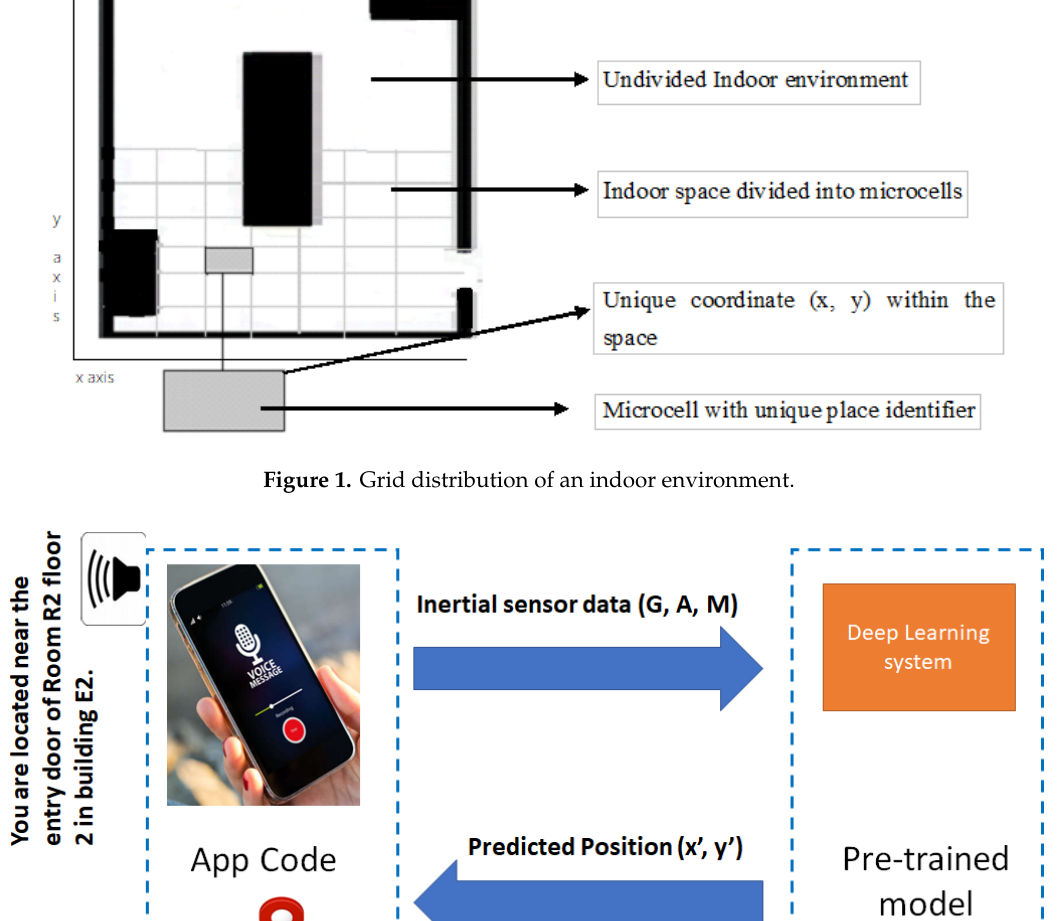
Figure 1. Grid distribution of an indoor environment.